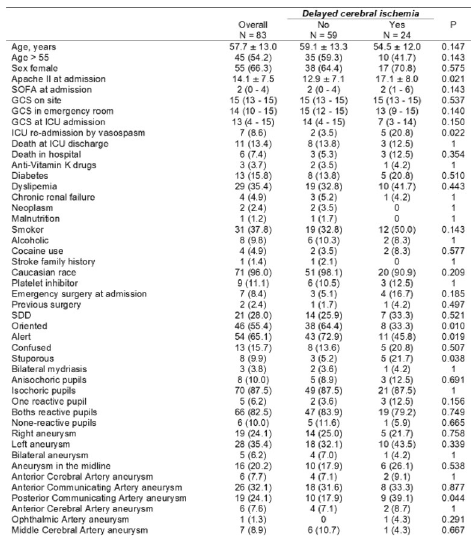
Table 1a (abstract 001113). Characteristics of the patients